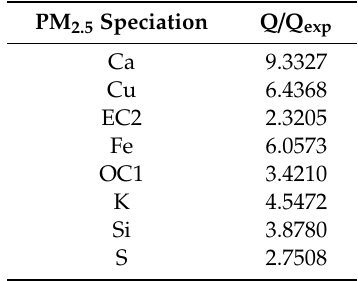
Table A2. Species with Q / Q exp > 2.